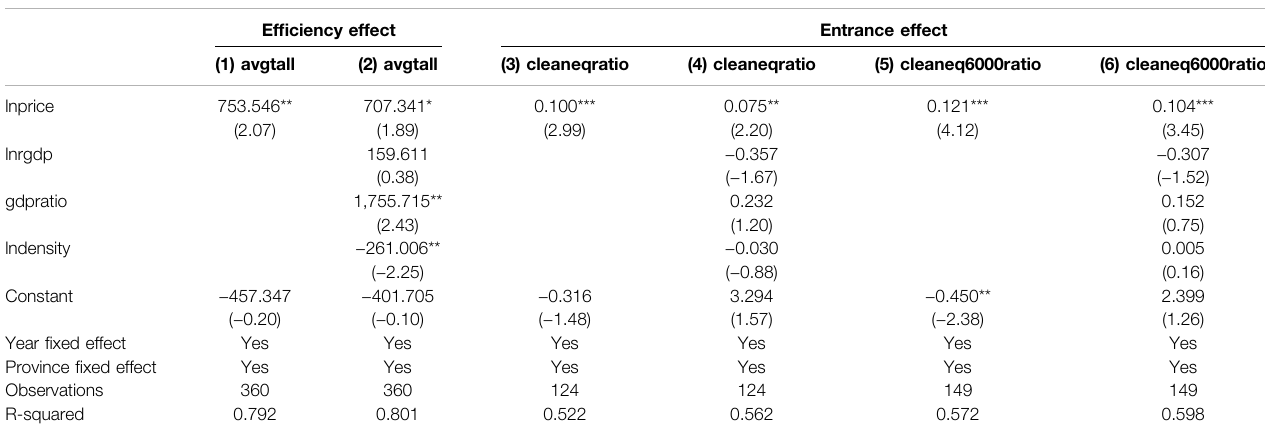
TABLE 4 | Mechanism